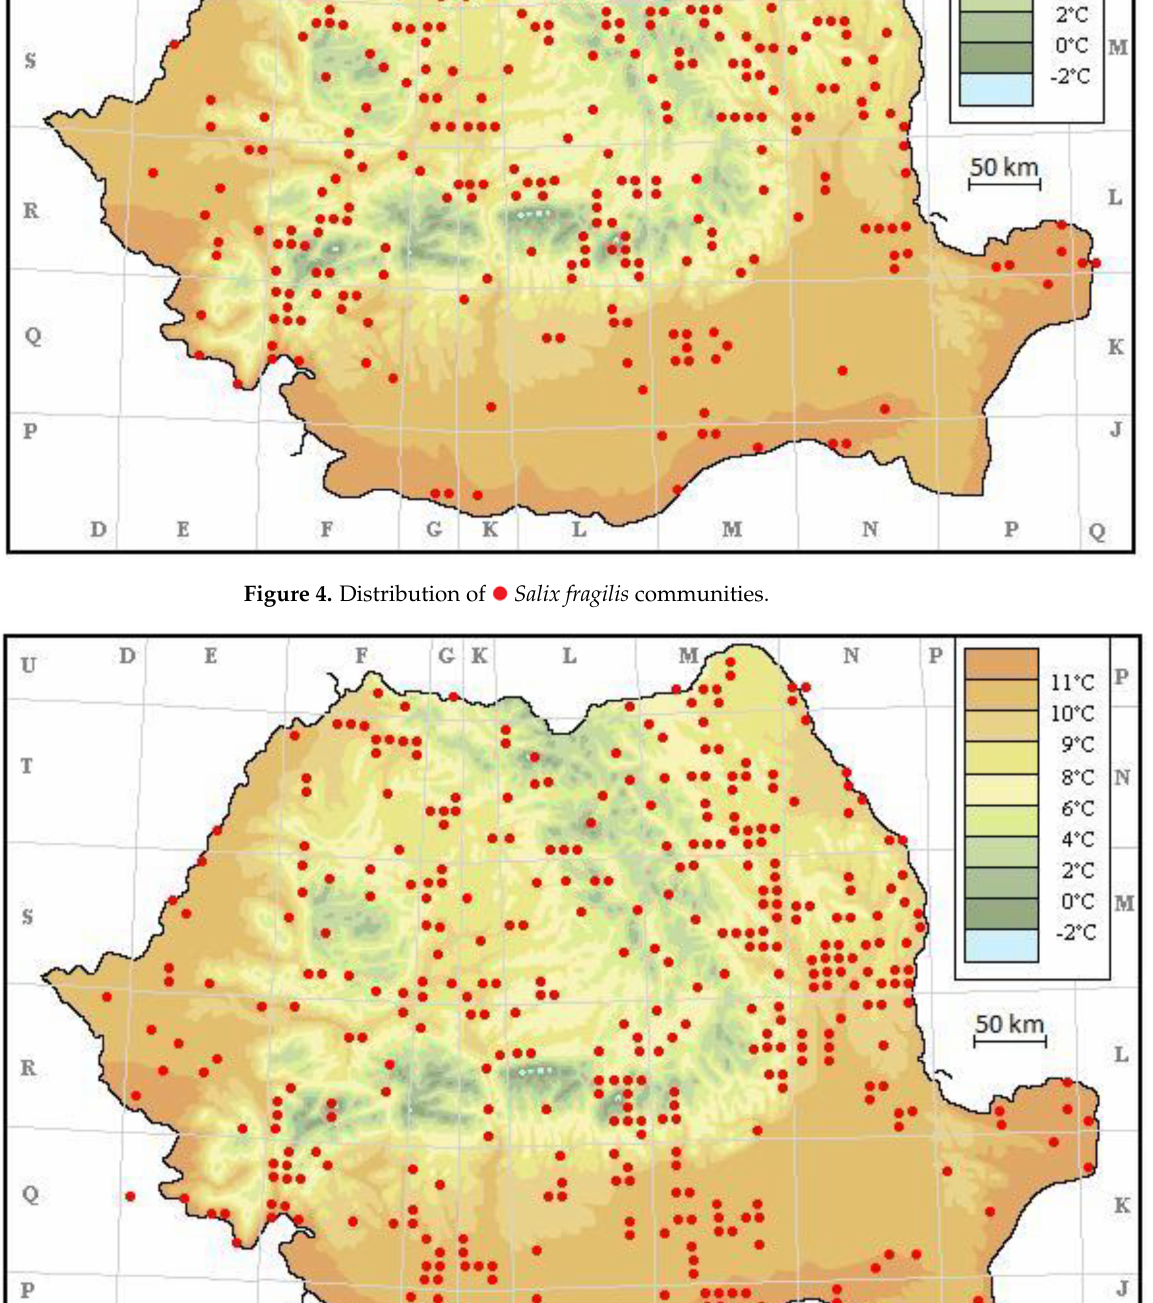
Figure 2. Data of Salix communities. ( a ) S. alba , ( b ) S. fragilis , ( c ) S. purpurea , ( d ) S. triandra